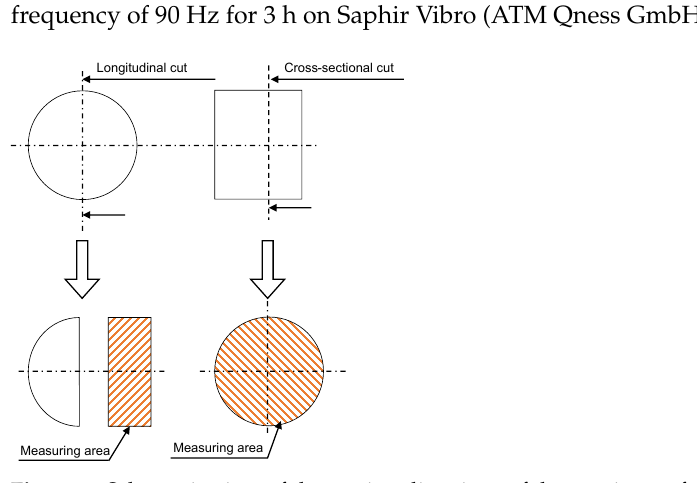
Figure 1. Schematic view of the cutting directions of the specimens for EBSD